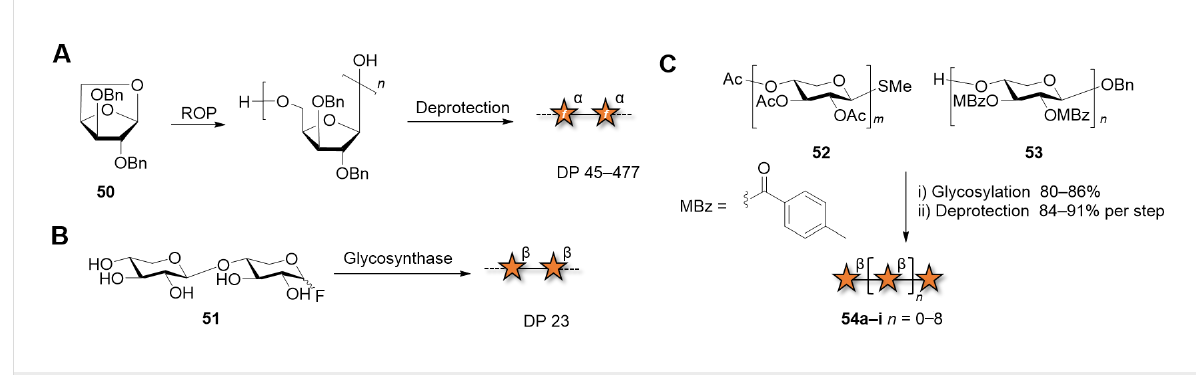
Scheme 7: Different approaches to produce xylans. A) Polymerization techniques including ROP, and B) enzymatic polymerization yielded non- uniform homopolymers. C) Chemical synthesis following a convergent approach provided short oligomers with control over